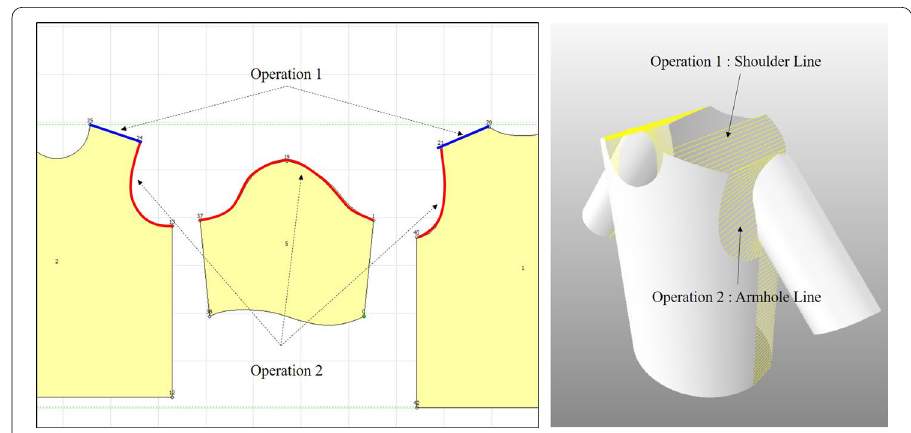
Fig. 9 Schematic diagram of two sewing